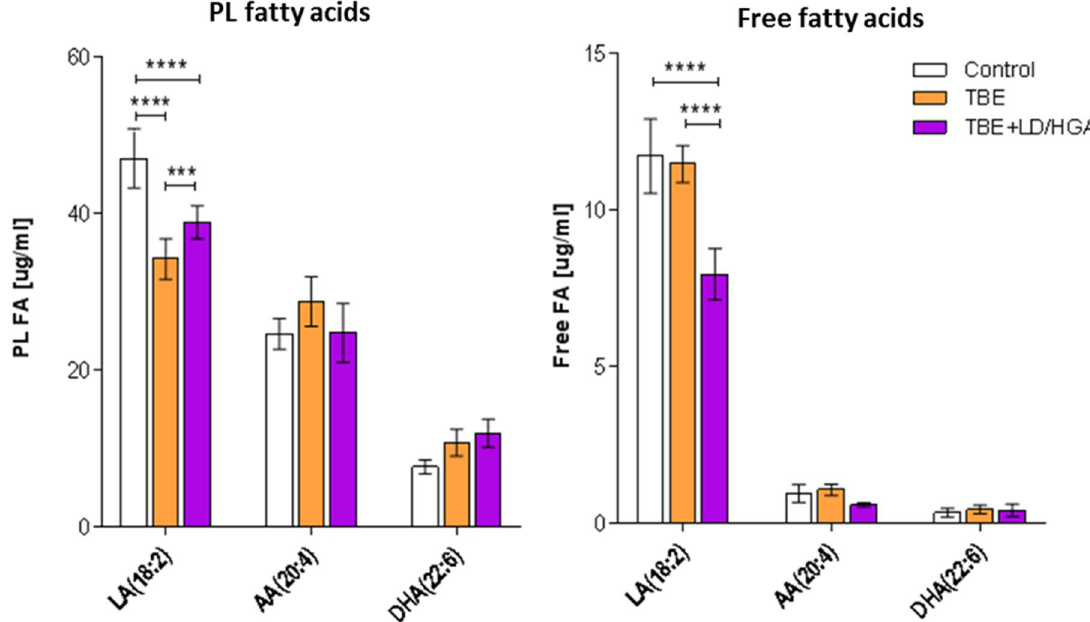
Figure 7. The levels of arachidonic (AA), linoleic (LA) and docosahexaenoic acid (DHA) in the plasma of healthy subjects (Control), TBE patients (TBE) and TBE patients co-infected with LD and HGA; left panel PL fatty acids, right panel free fatty acids, ***p < 0.001, ****p <